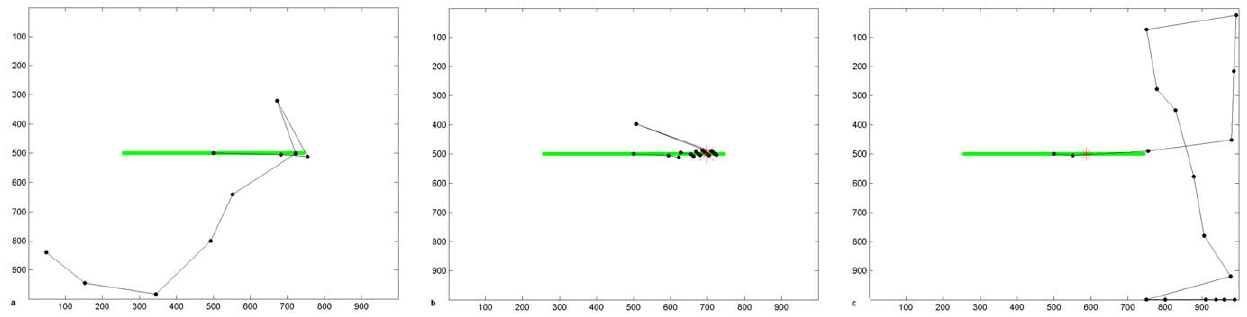
Figure 6. Line Scanning and Bisection with Spatial Compensation. (a–b) Hemianopic scanpath under (a) free viewing, where the model can scan the blind hemifield but does not accurately fixate the line and (b) with the line bisection task, where the task bias does bring the scanpath back to the target line, but only the ipsilesional line segment is viewed, and the bisection point is offset to this side (in this example position 697, a 17.9 u offset, or ipsilesional error of 39.8% of line length). Hence spatial compensation alone does not reproduce real hemianopic performance for this task. (c) Hemineglect scanpath during a line bisection task. During this task and under free viewing (not shown), the contralesional line segment is severely neglected and the scanpath deviates from the line. The bisection point is shifted to the ipsilesional part of the line (in this example position 587, 7.9 u offset, or an ipsilesional error of 17.6% of line length). This spatial bias is, again, ineffective in promoting contralesional scanning in hemineglect. Axes refer to pixel position in the